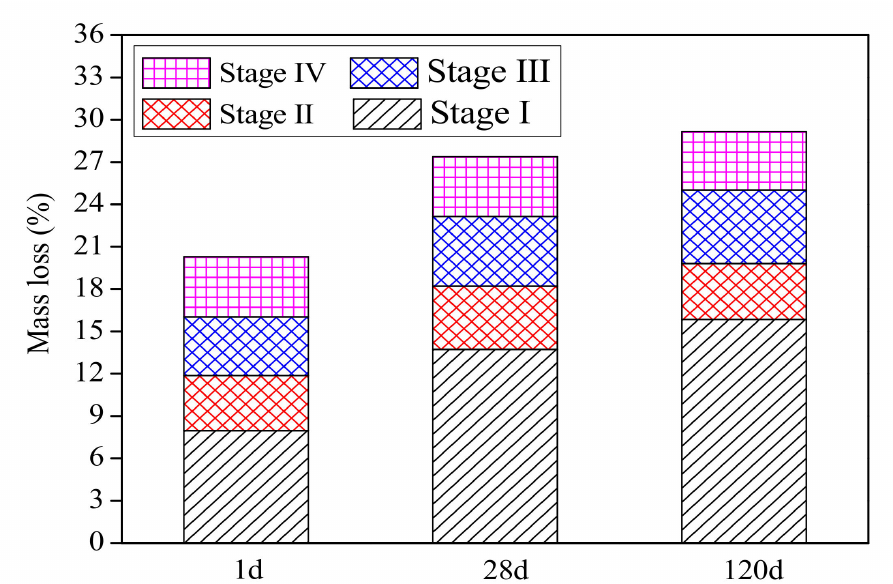
Figure 11. The mass loss at different stages for the CSAC-GGBFS mixture with 6% FGDG hydrated for different time